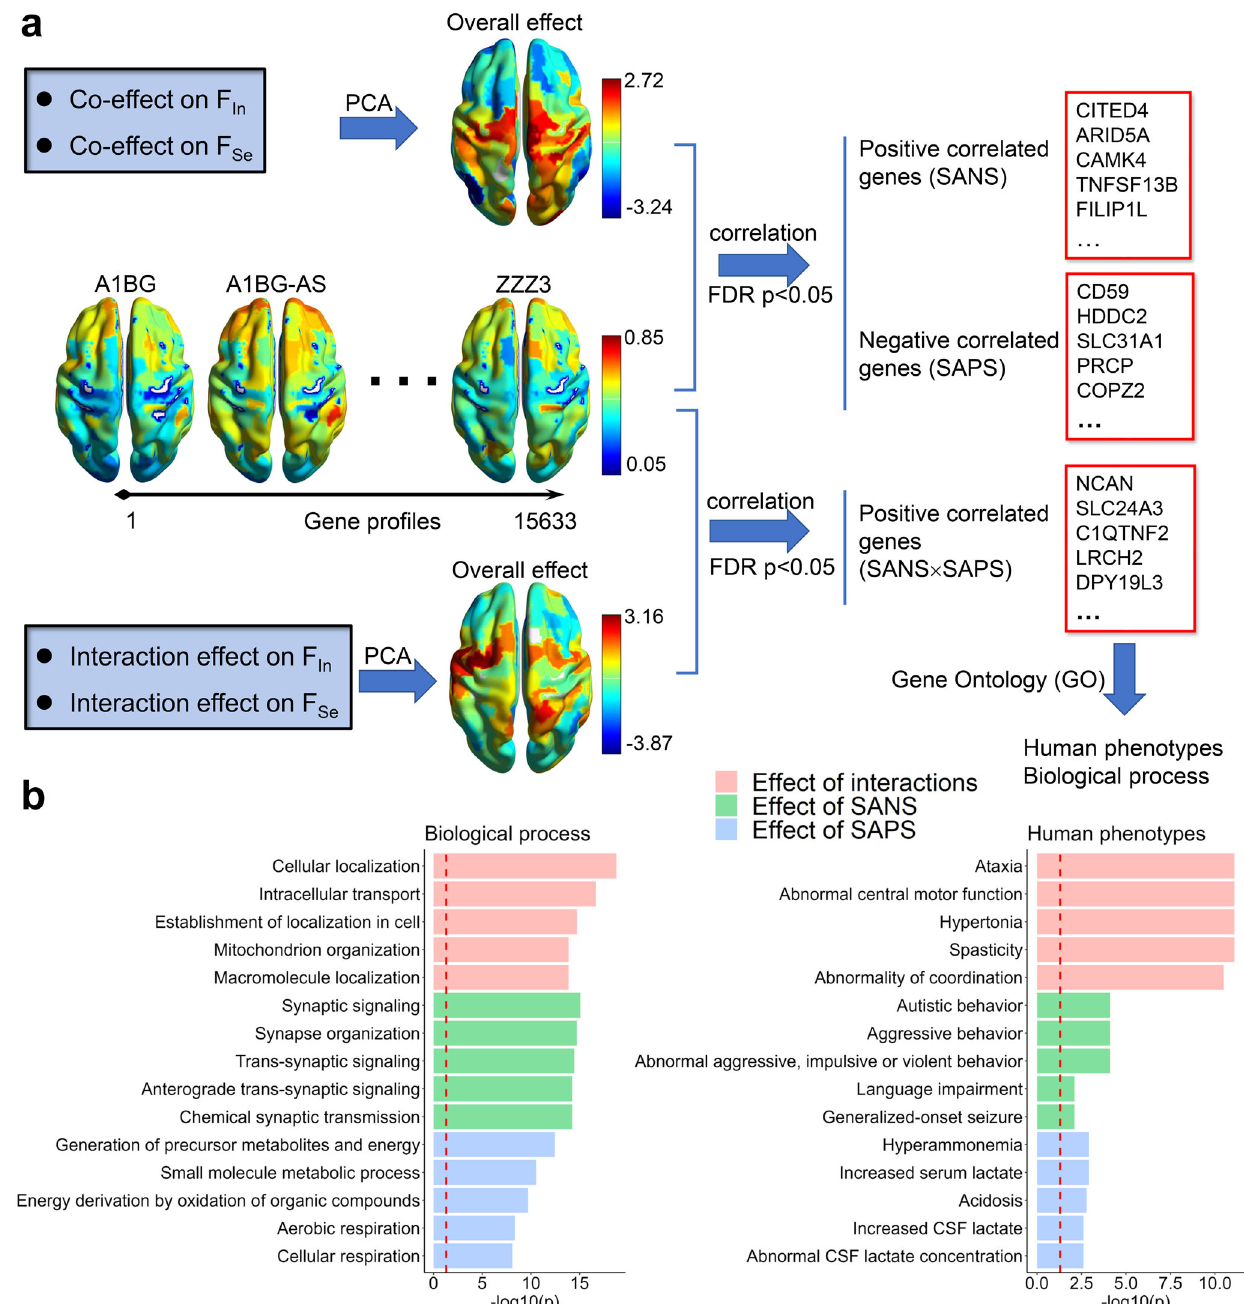
Fig. 5 Effects of schizophrenia symptoms and gene pro fi les. a The pipeline of gene selection for SANS, SAPS, and SANS × SAPS interaction effects. The correlations between the overall effect and gene transcriptional pro fi les were calculated to identify signi fi cant genes ( p < 0.05, FDR corrected). b Top fi ve gene ontology (GO) enrichment results for biological processes and human phenotypes using ToppGene, showing speci fi c functional relevance (see similar results for the brain parcellation of 500 regions in Supplementary Fig.